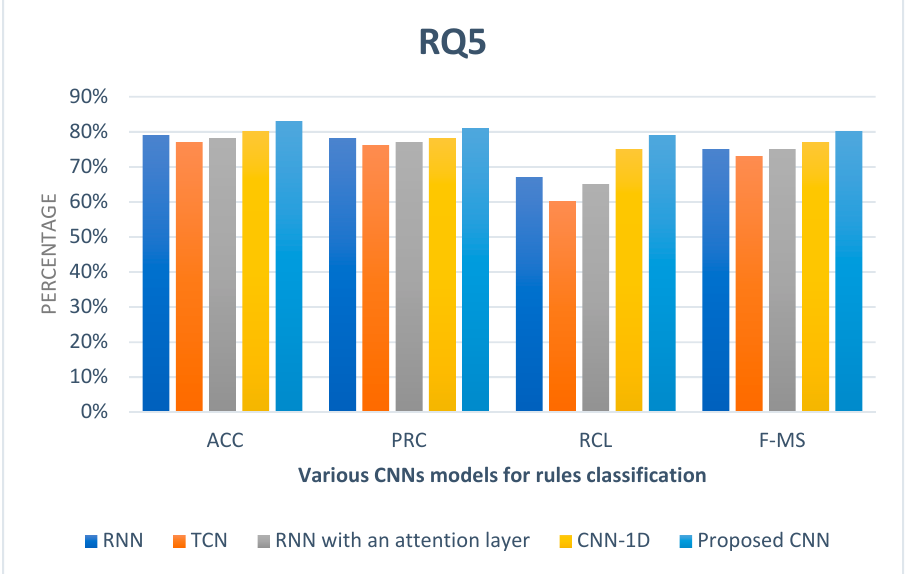
Figure 17. The verification time of the CNN model to verify rules.